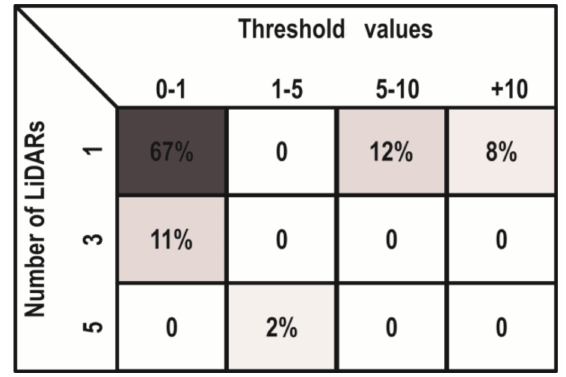
Figure 8. Q-learning classification error